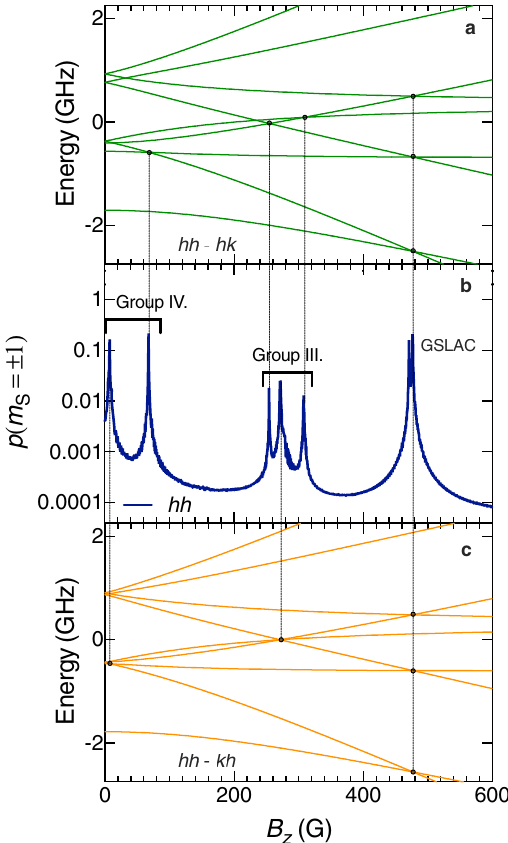
Fig. 7 Identi fi cation of resonance peaks for the hh divacancy interacting with other divacancy centers. a and c show the energy levels structure of hh divacancy- hk divacancy and hh divacancy- kh divacancy two spin systems, respectively. At zero magnetic fi eld, the spin states split into three well-separated manifolds. b depicts the derived spin population curve for the hh